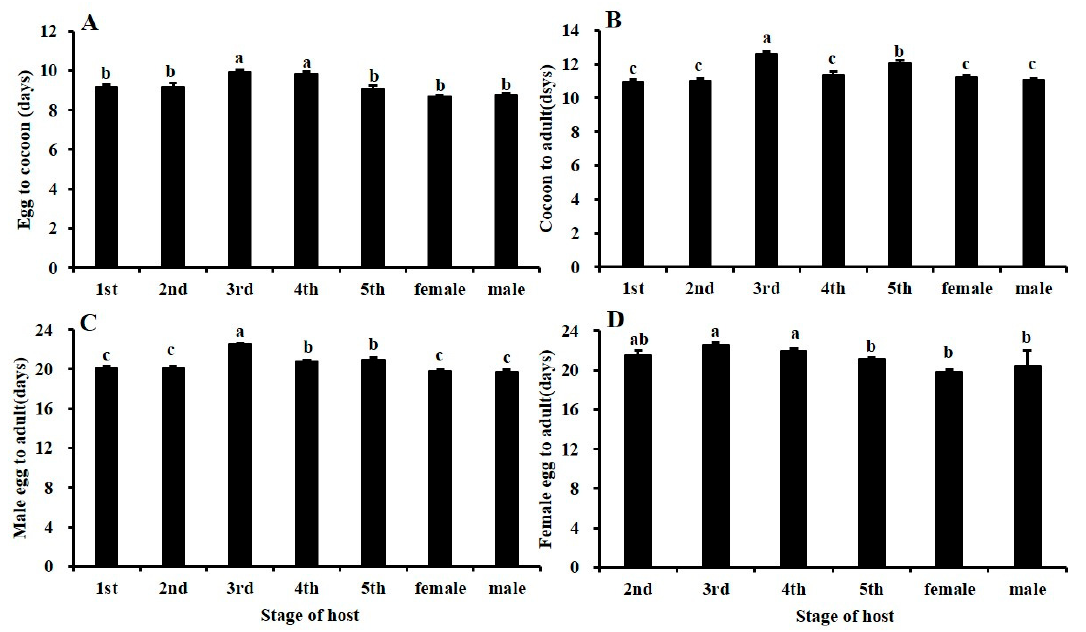
Figure 4. Effects of BPH life stage on the time required for the development of Gonatopus flavifemur : ( A ) egg to cocoon, ( B ) cocoon to adult, ( C ) egg to adult (male), and ( D ) egg to adult (female).